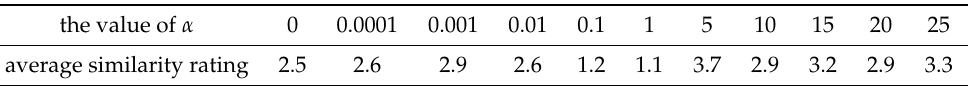
Table 2. α -wise similarity ratings on linearly interpolated digits from two-component VAEs in EVAE. the value of α